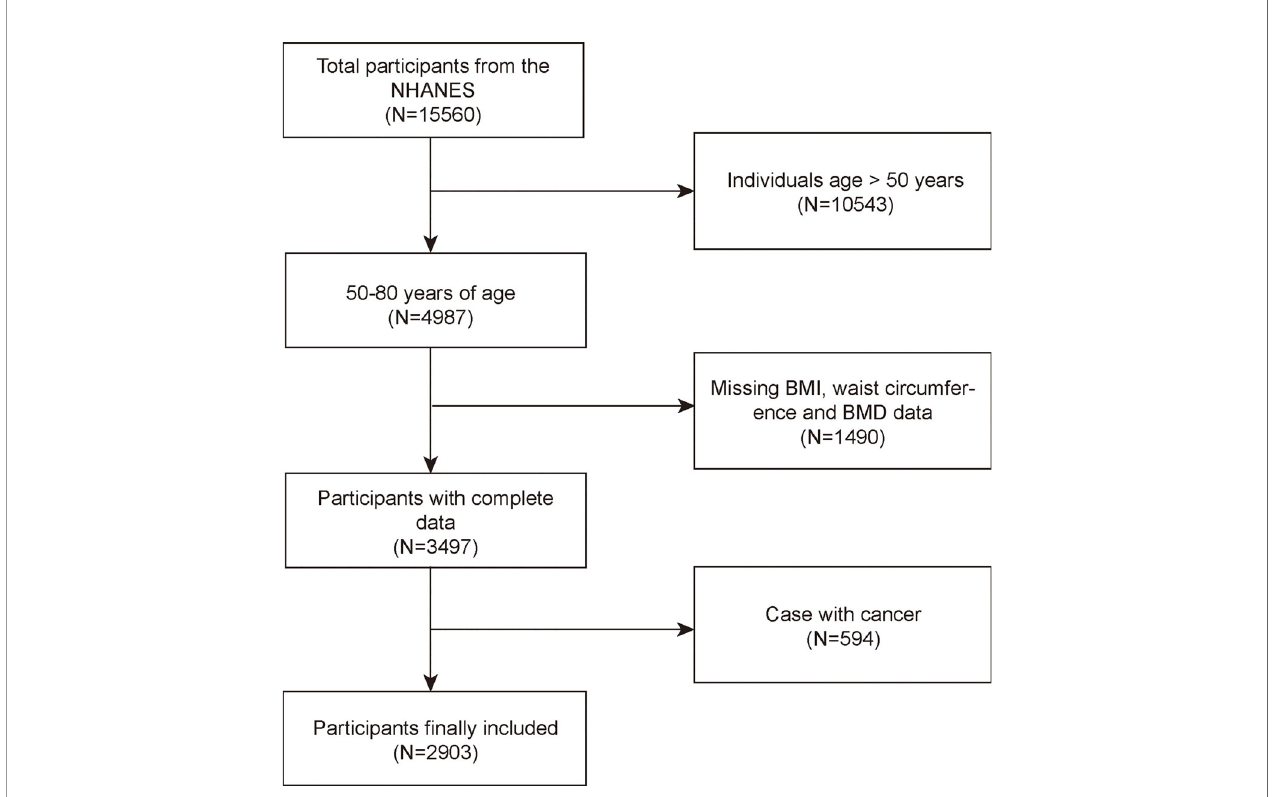
FIGURE 1 | Flowchart of participant selection. NHANES, National Health and Nutrition Examination Survey; BMD, bone mineral density; BMI, body mass index; WC, waist